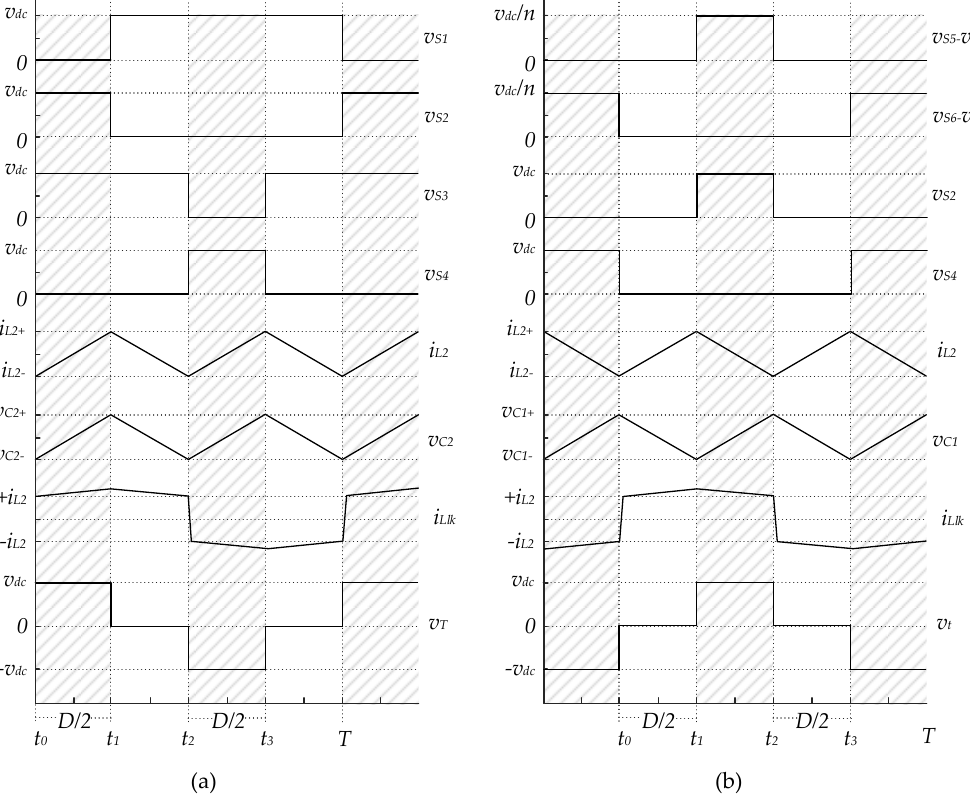
Figure 5. Theoretical waveforms of the converter operating in: ( a ) Step-down mode during the batteries’ charge, ( b ) step-up mode during the batteries’ discharge.